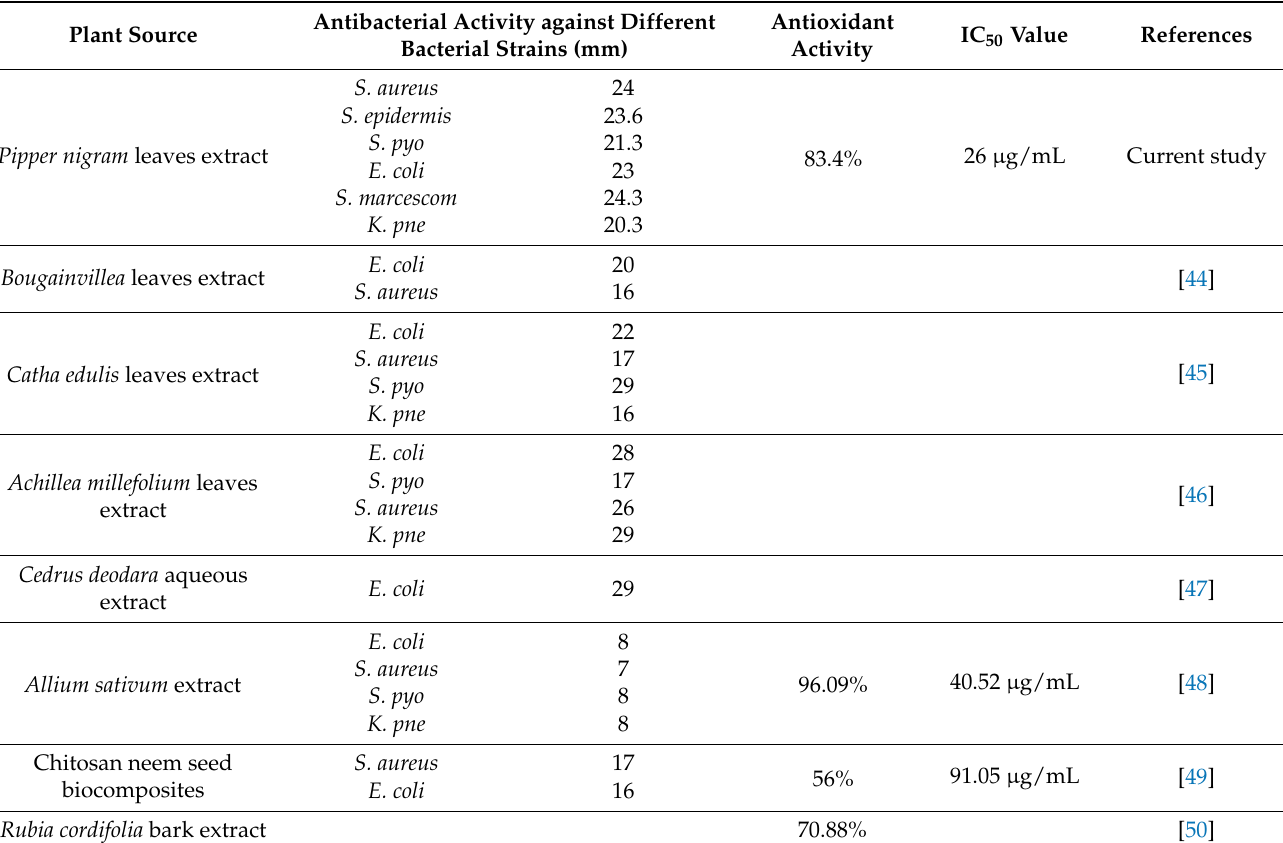
Table 3. Comparison of antibacterial and antioxidant activities of CuO NPs synthesized by different plant species with CuO NPs synthesized in the present